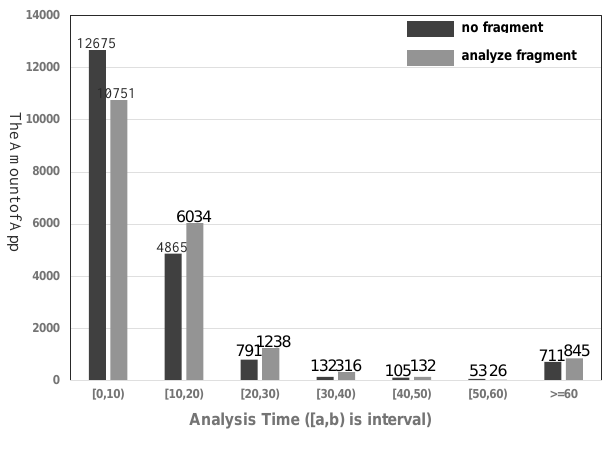
Figure 12. Distribution of Analysis Time